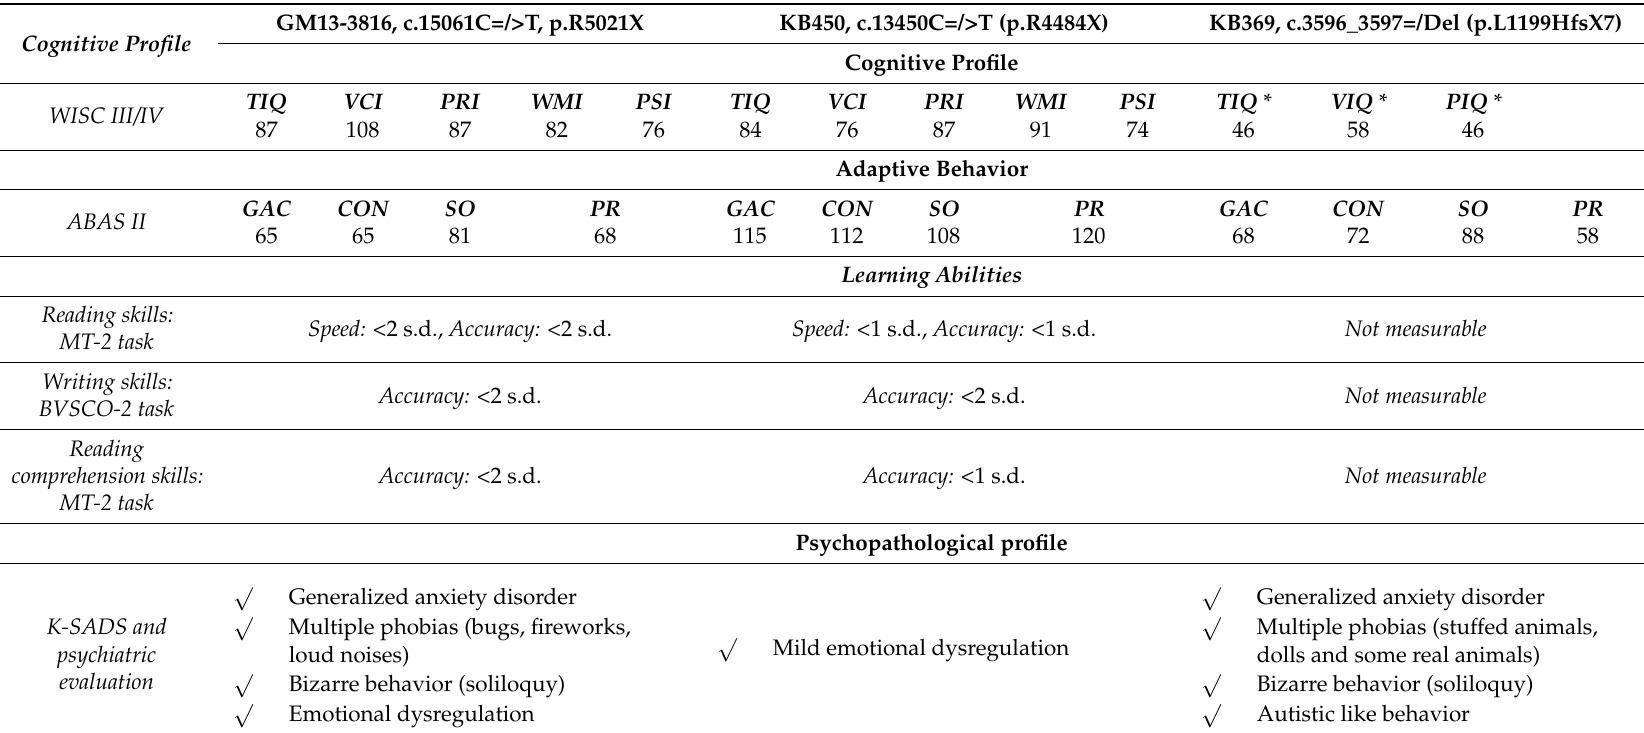
Table 2. Summary assessment of neurobehavioral